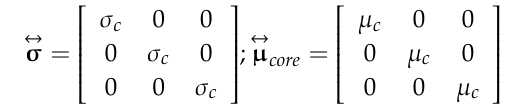
Figure 7. Synthesis of equivalent B ( H ) measurement: ( a ) equivalent anhysteretic B ( H ); ( b ) equivalent relative permeability µ r ; curves based on 3C90 datasheet (black) and measurement: T2 supply of A and B windings (red), T2 supply of B and C windings (green), T2 supply of C and A windings (blue)— the same as in Figure 6, T1 supply of A and B windings (cyan), T1 supply of B and C windings (yellow), T1 supply of C and A windings (magenta).